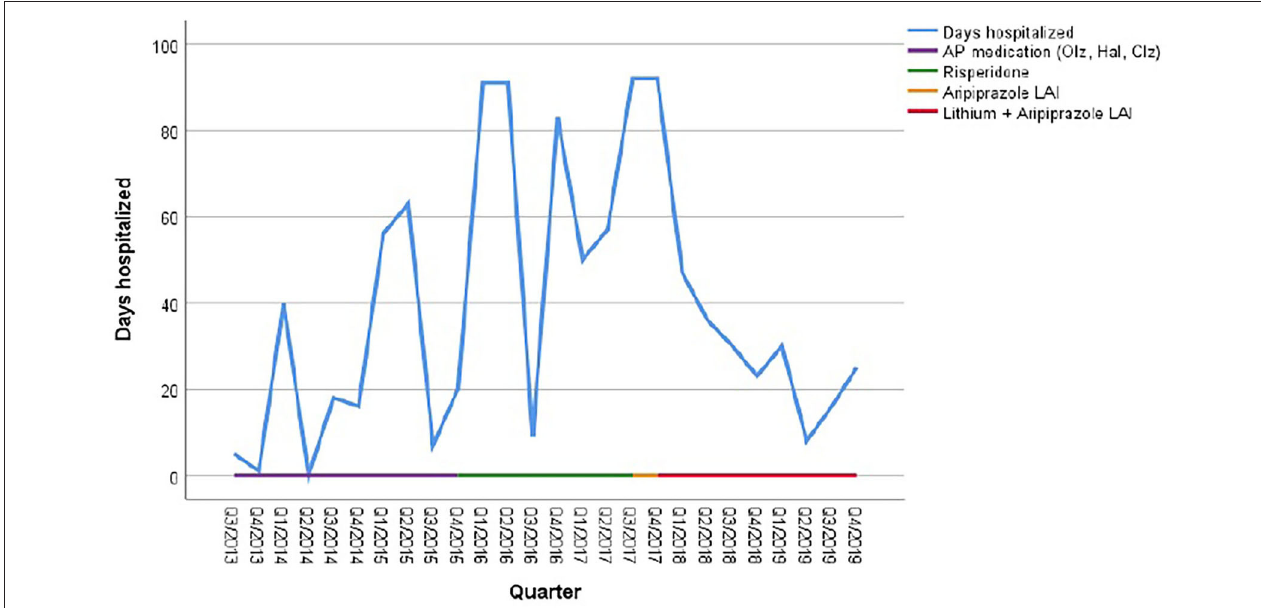
FIGURE 1 | Cumulative duration of hospitalization in relation to psychotropic medication. AP, antipsychotics; Olz, olanzapine; Hal, haloperidol; Clz, Clozapine.